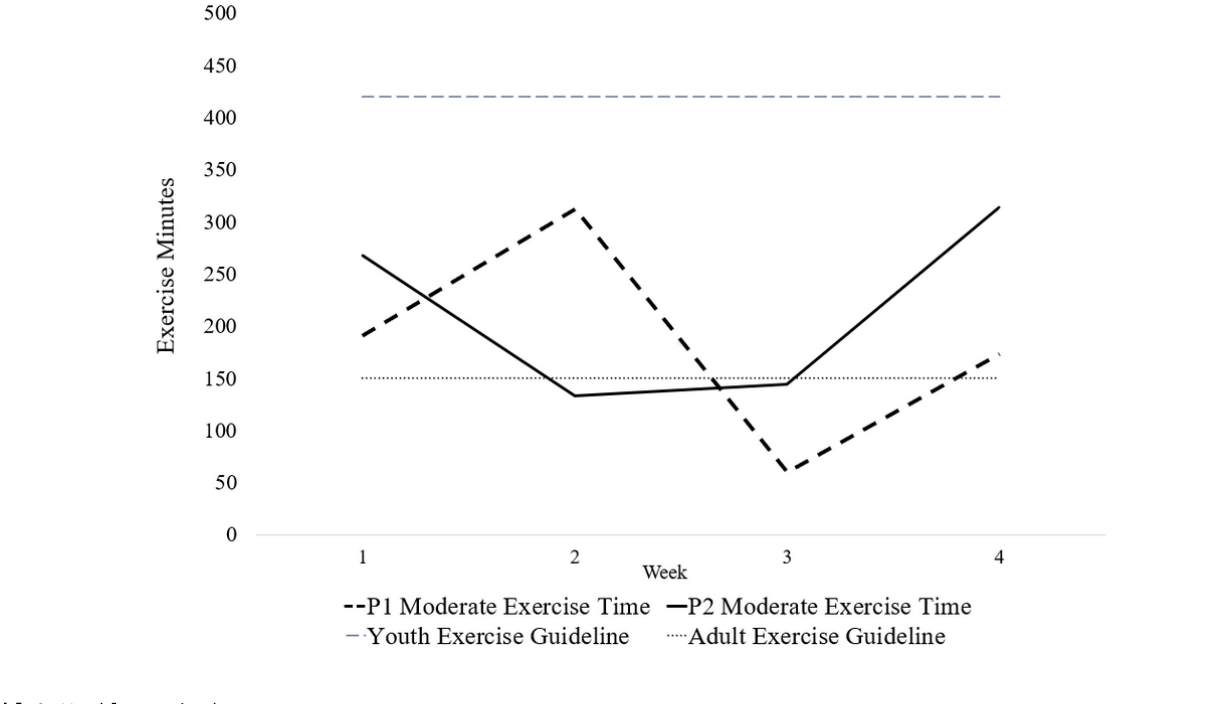
Table 2. Weekly exercise data. Moderate-intensity exercise (minutes), n/N